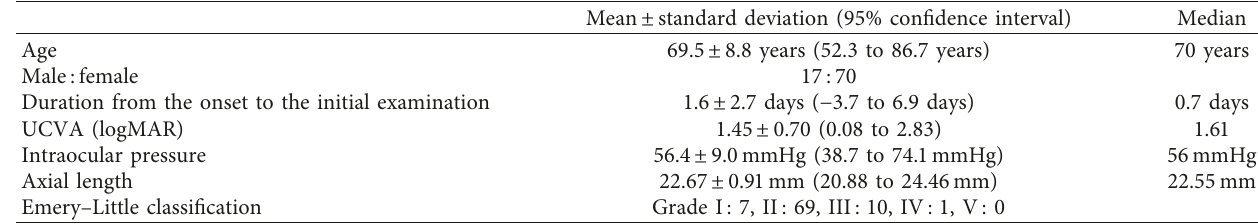
Table 1: Pretreated demographics of the study population for acute primary angle closure.